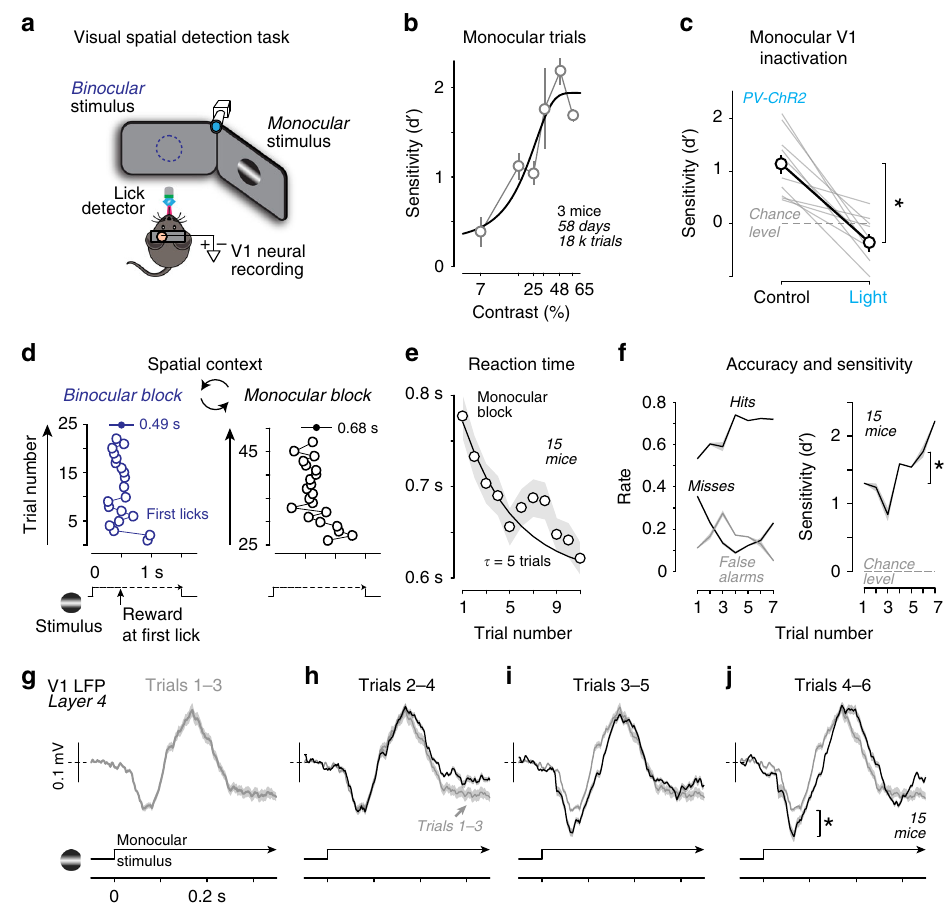
Fig. 1 Spatial context improves behavior and strengthens LFP responses. a Visual spatial detection task. Mice were head- fi xed and stationary in a semi- enclosed plastic tube. Mice faced two computer monitors and performed the task during simultaneous measurements of licking, pupil, and neural activity. Stimuli appeared in either binocular or monocular visual space. b Monocular detection sensitivity (d ’ ) increases as a function of contrast ( n = 3 mice, 58 behavioral sessions, >18,000 trials). These mice were trained extensively at the exact same contrast ranges, and are part of the population analyzed throughout the study. Dark curve shows psychometric fi t. c Optogenetic inhibition of monocular V1 (interleaved on 25% of trials) signi fi cantly impaired monocular detection sensitivity (d ’ , 1.13 ± 0.19 to − 0.36 ± 0.18; mean ± SD; p < 0.01; Wilcoxon signed-rank test; n = 10 days and 1575 trials). During inactivation, d ’ was not signi fi cantly different from chance level ( p < 0.01, sign test). Data from two PV-cre x A1-32-ChR2 mice. See also see Supplementary Fig. 1. d Example session of visual spatial detection during neural recordings. Stimuli (gratings) appear in binocular (blue) or monocular (black) visual fi elds, in blocks of consecutive trials at each location. Blocks alternate repeatedly within session (after 25 trials in this example). Rewards delivered upon fi rst lick (circles, correct detection) during stimulus window. Reaction times: binocular, 0.49 ± 0.08 s; monocular, 0.68 ± 0.1 s. Mean ± s.e.m. e Reaction time improves signi fi cantly across consecutive trials within block (15 mice; 143 blocks; p < 0.05, Wilcoxon rank-sum test, throughout fi gure). Mean ± s.e.m., monocular trials. Time constant ( τ ) of improvement = 4.5 trials (exponential fi t). f Detection accuracy and sensitivity improve signi fi cantly across same trials as in e . Left, hit rate increases 27% ( p < 0.001, rank-sum test), miss rate decreases 50% ( p < 0.001), false alarm rate decreases 16% ( p = 0.4) from Trials (1 – 3) to Trials (4 – 6) . Right, psychometric sensitivity (d ’ ) increases signi fi cantly across same trials (Trial (1 – 3) :1.1 ± 0.1; Trials (4 – 6) : 1.6 ± 0.1; mean ± s.e.m.; p < 0.001, rank-sum test ) . g – j Local fi eld potential (LFP) responses in Layer 4 of primary visual cortex (V1) during same behavioral sessions as e and f . LFP response increases signi fi cantly from trials 1 to 3 ( g , gray) to trials 4 to 6 ( j , black; 72% increase; [Trials (4 – 6) Trial (1 – 3) ]/Trial (1 – 3) ; p < 0.01, sign test). Mean± s.e.m. across correct trials. Dashed line at 0 mV. Fifteen mice, 21 recording sessions in monocular V1 (see Supplementary Fig.